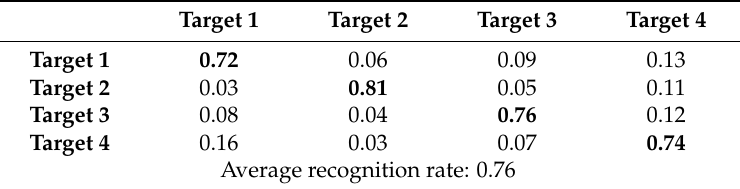
Table 7. Real data recognition result for the SSM-OMP